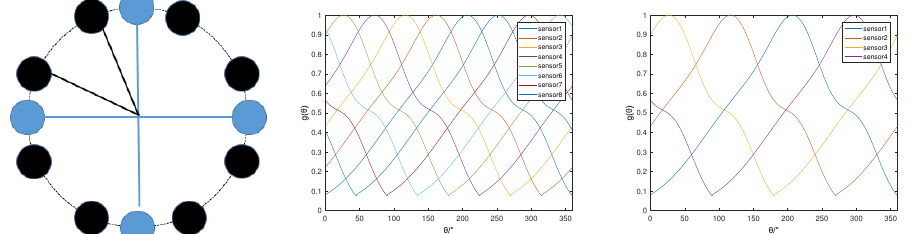
Figure 6. Array diagram and AGAR with different number of elements. ( a ) Array diagram. ( b ) AGAR (N = 8). ( c ) AGAR (N =